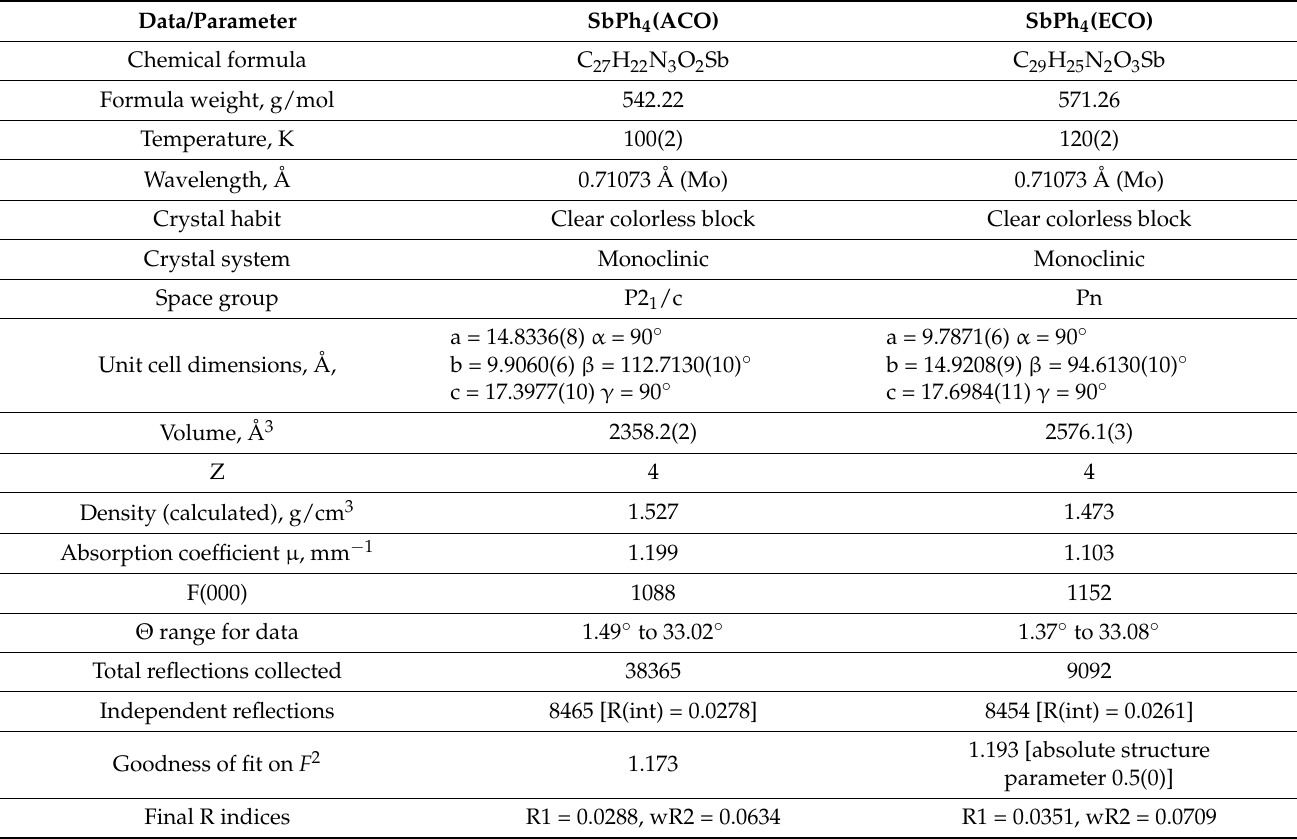
Table 4. Crystal data for tetraphenyl-antimony(V)